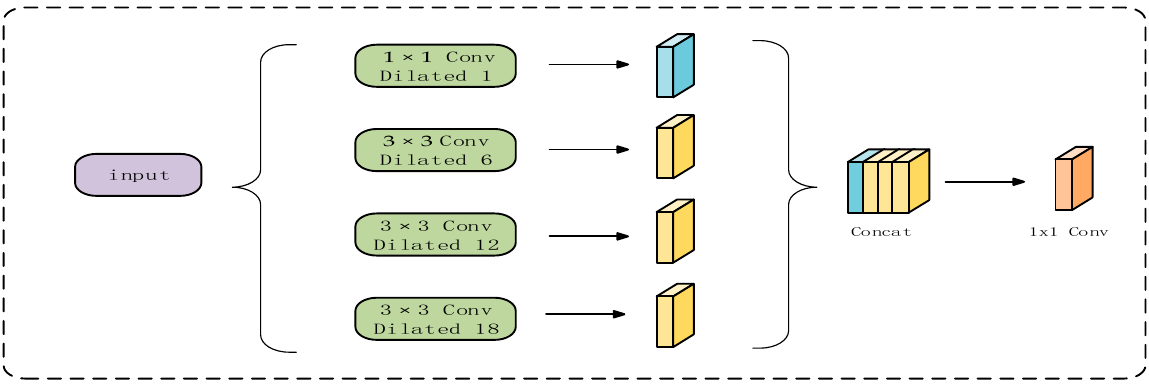
Figure 3. Atrous spatial pyramid pool.